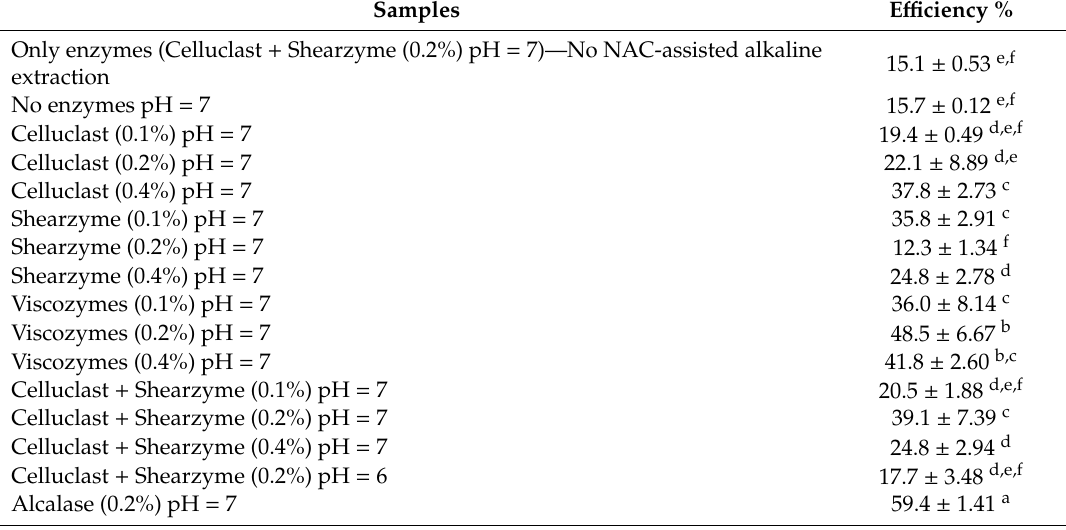
Table 2. Protein extraction e ffi ciency (%) of the seaweed Eucheuma denticulatum treated with di ff erent enzymes followed by NAC-assisted alkaline extraction. Results are given as avearge ± standard deviation. Di ff erent superscripts letters in the same column indicate significant di ff erence at the confidence level of 95% ( α = 0.05; n =